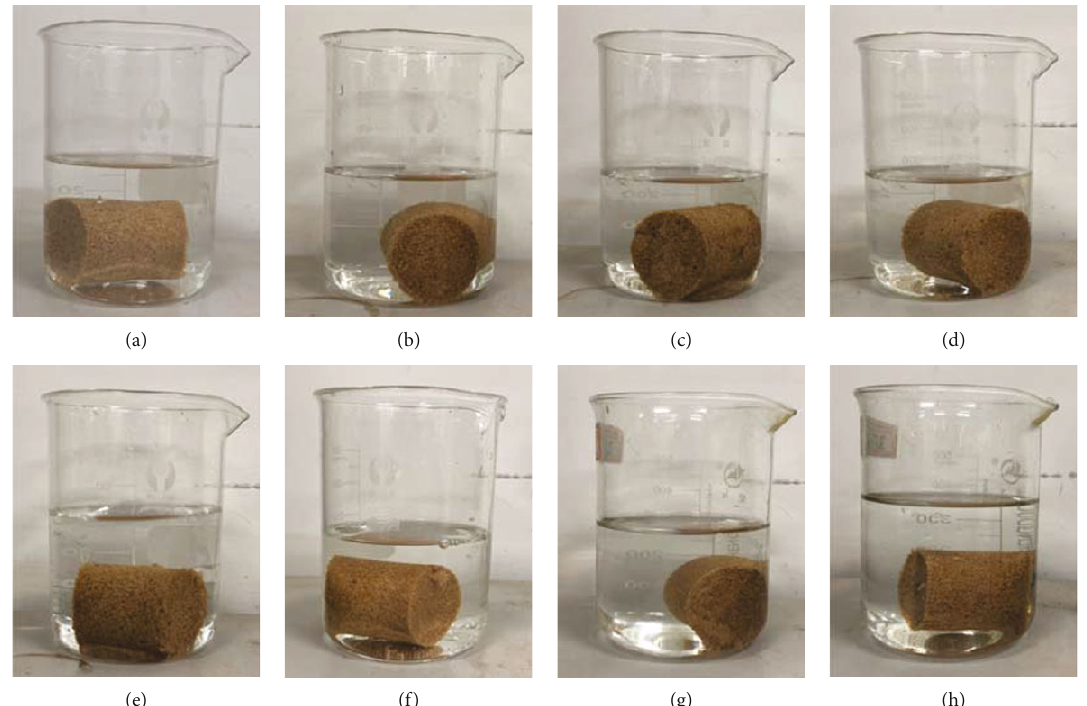
Figure 10: The state of the specimens with di ff erent immersion times after oscillating: (a) 0h; (b) 1h; (c) 3h; (d) 6 h; (e) 12 h; (f) 24 h; (g) 48 h; (h) 72 h.